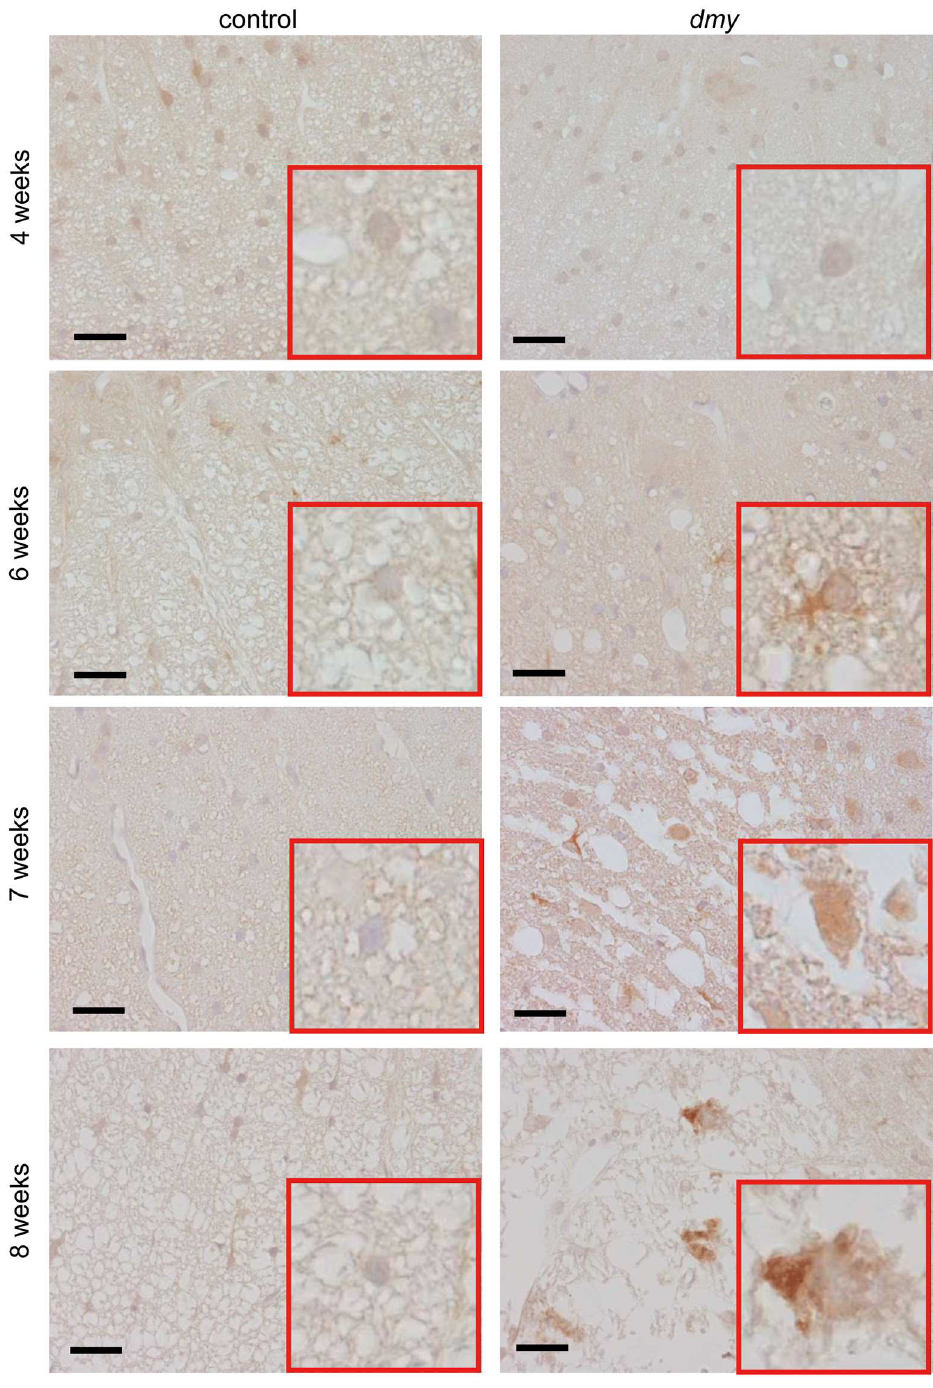
Fig 6. Immunohistochemistry for Golgi 58K. The immunohistochemistry for Golgi 58K in the lumbar spinal cords from the dmy rats at 4, 6, 7 and 8 weeks of age. The immunoreactivity for the Golgi apparatus is elevatedin the ventral funiculusof the dmy rats at 6–8 weeks of age. Bars: 20 μ m.